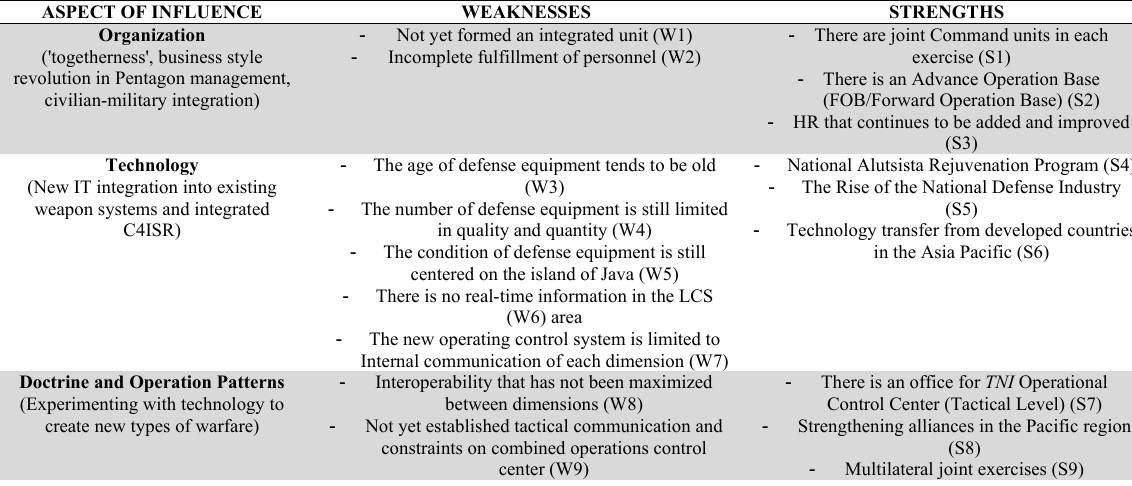
Internal Factor Analysis ASPECT OF